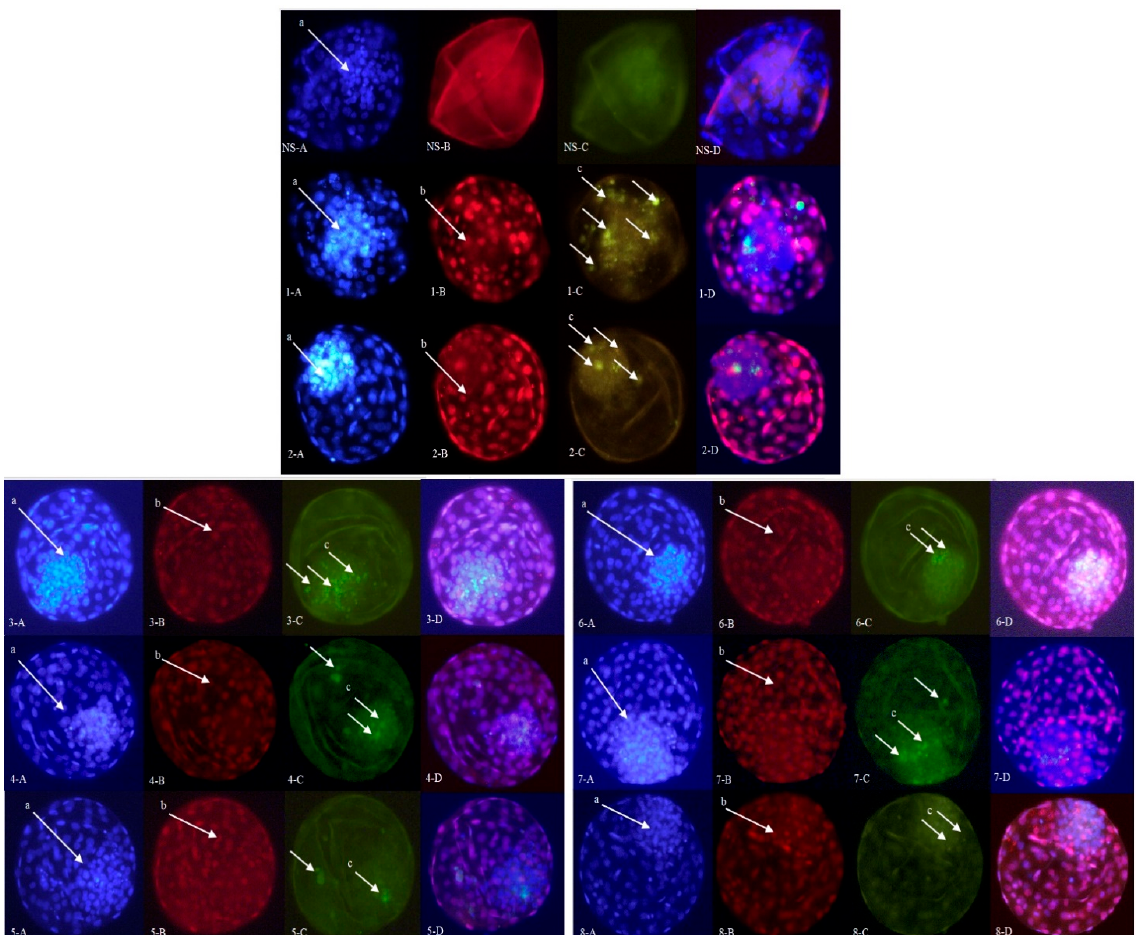
Figure 2. Differential apoptotic staining of the expanded blastocysts (eight groups) (A–D). Representative blastocysts of all groups (1–8) are presented (see Experimental Design of the Materials and Methods and Figure 4 for details). NS: negative staining control. Both the trophectoderm (TE) and inner cell mass (ICM) (arrow a) nuclei were stained with Hoechst (1.A–8.A). The CDX2 antibody (labeled with Texas Red) resulted in a red fluorescent signal in TE cells (arrow b) (1.B–8.B). Apoptotic cells (arrow c) showed a green fluorescent signal (anti-caspase 3 antibody labeled with FITC) (1.C–8.C). Merged pictures (1.D–8.D) (40× magnification).